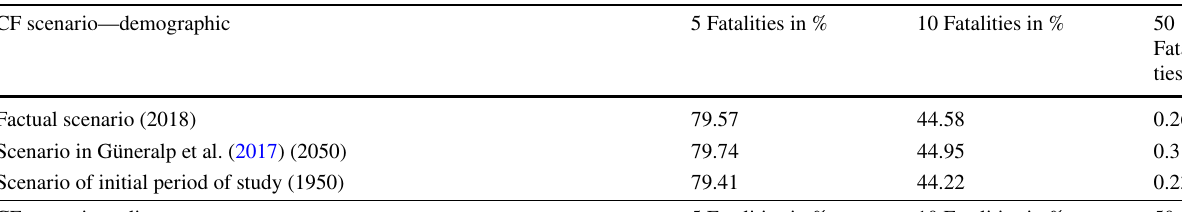
Table 5 Counterfactual (CF) calculations for different demographic and climatic scenarios CF